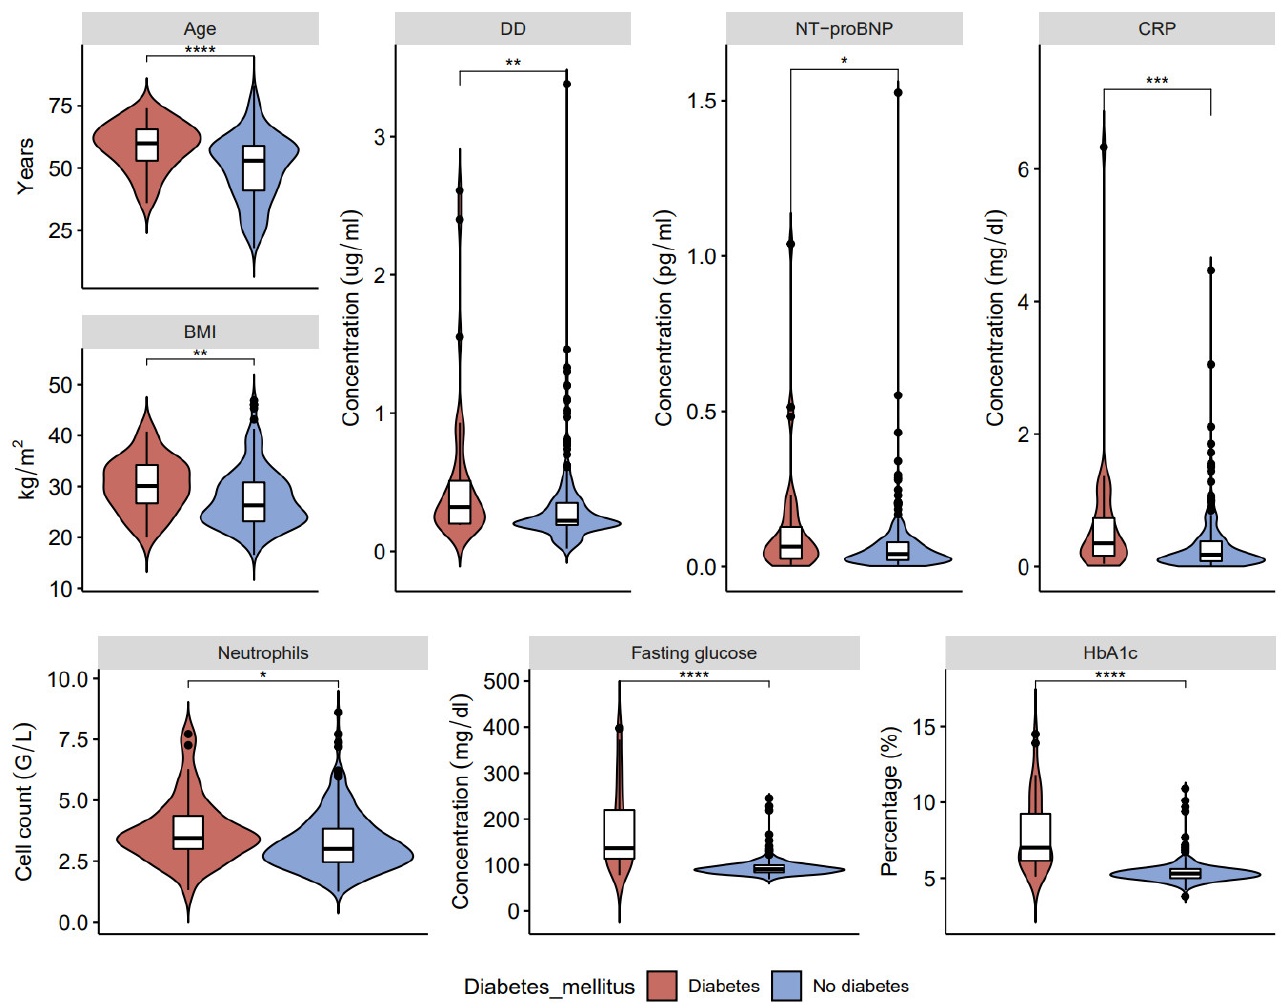
Figure 2. Clinical characteristics and laboratory results of blood samples in post-COVID-19 patients with and without type 2 diabetes: age, D-dimers (DD), ventricular natriuretic peptide (NT-proBNP), C-reactive protein (CRP), body mass index (BMI), neutrophils, fasting glucose, and glycated hemoglobin (HbA1c) (* p < 0.05, ** p < 0.01, *** p < 0.001, **** p < 0.0001). Immunological test results showed that SARS-CoV19 IgM antibodies were present in nine subjects (2.88%). Among those, five participants had follow-ups in the 5th month after the onset of the disease, while the other four participants had follow-ups in the 6th month. SARS-CoV19 IgG antibodies were present in 241 subjects (77.2%) and were <10 AH/mL in 71 participants (22.8%). Meanwhile, increased CMV IgG titers defined as >0.5 U/mL were present in almost all 312